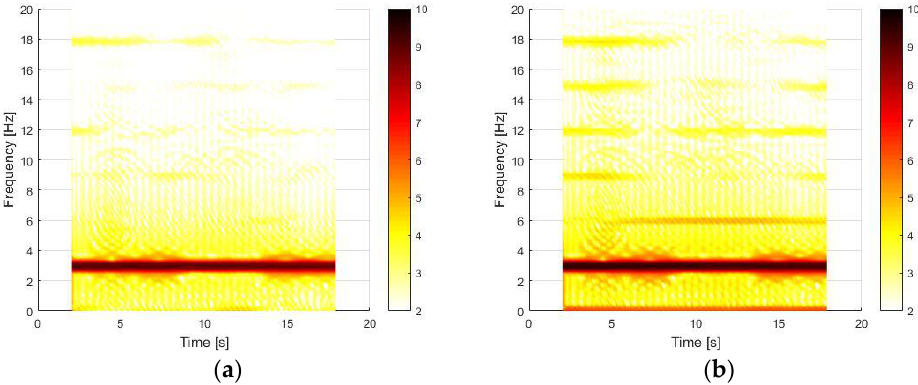
Figure 10. Time – frequency contents of “BD” for P11 (intermedial) ( a ) and P14 (mass) ( b ) profilometer points.